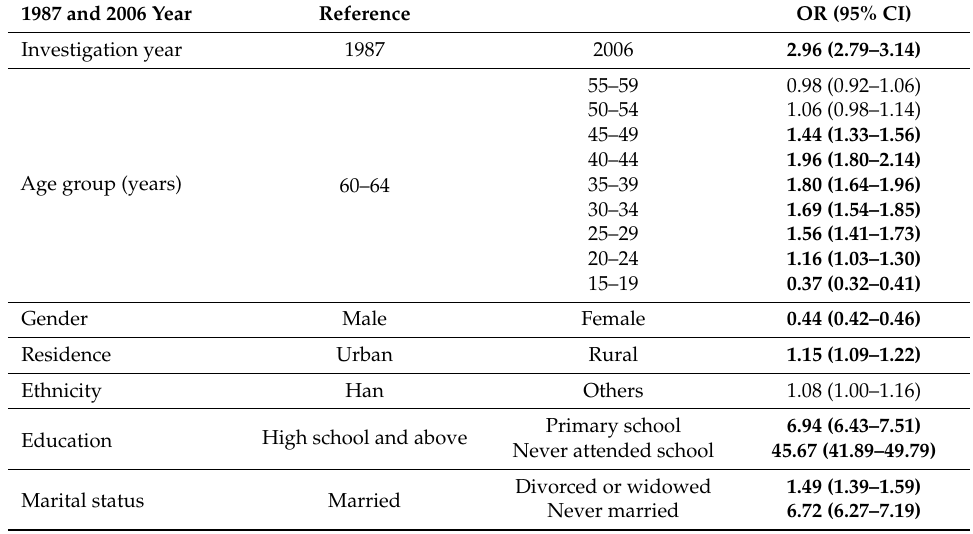
Table 4. Associations of multiple disabilities (yes/no) in Chinese population aged